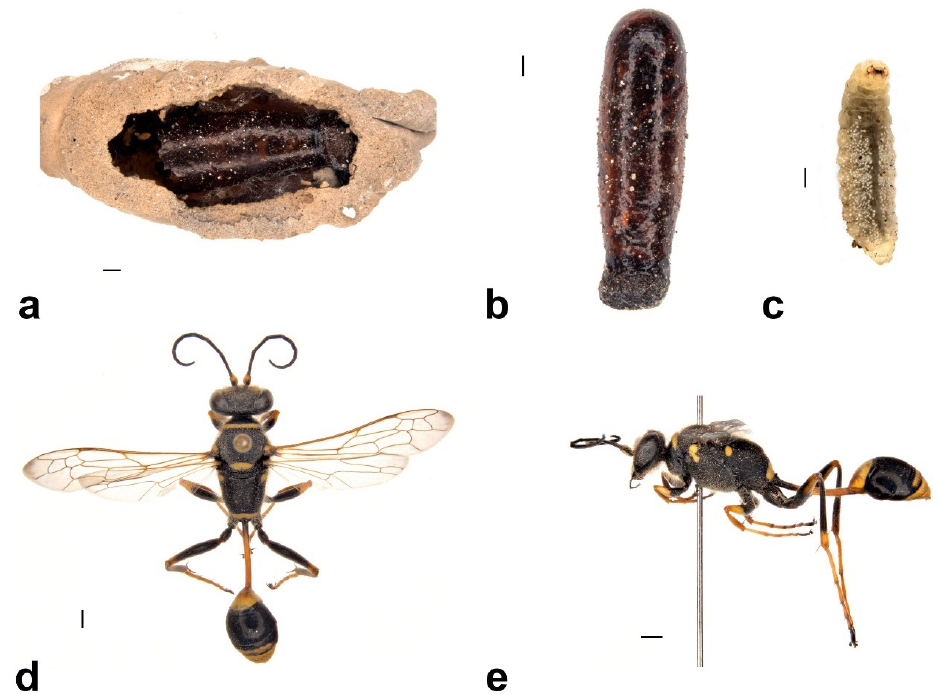
Figure 7. Larva, cocoon, mud nest and adult of Sceliphron formosum : ( a ) ventral view of the mud nest that contained emptied debris of cocoon, ( b ) cocoon that contained a nearly emerged pupa, ( c ) ven- tral view of a larva, ( d ) ventral view of male adult, and ( e ) lateral view of male adult. Scale bar = 1